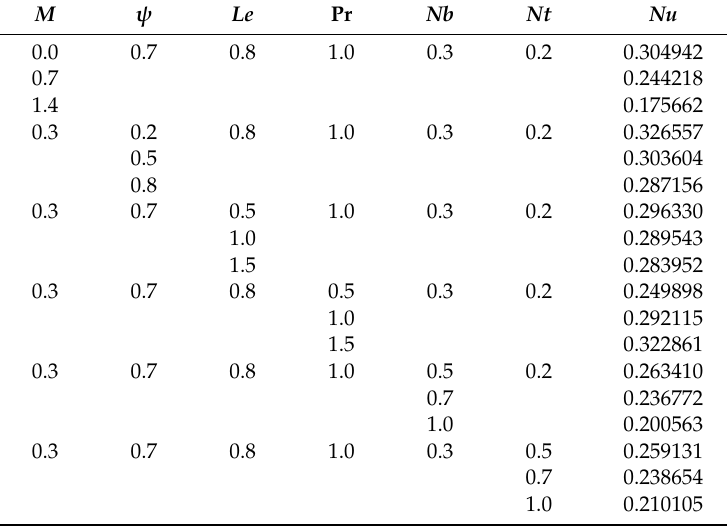
Table 2. Results of Nu against M , ψ , Le , Pr, Nb and Nt .